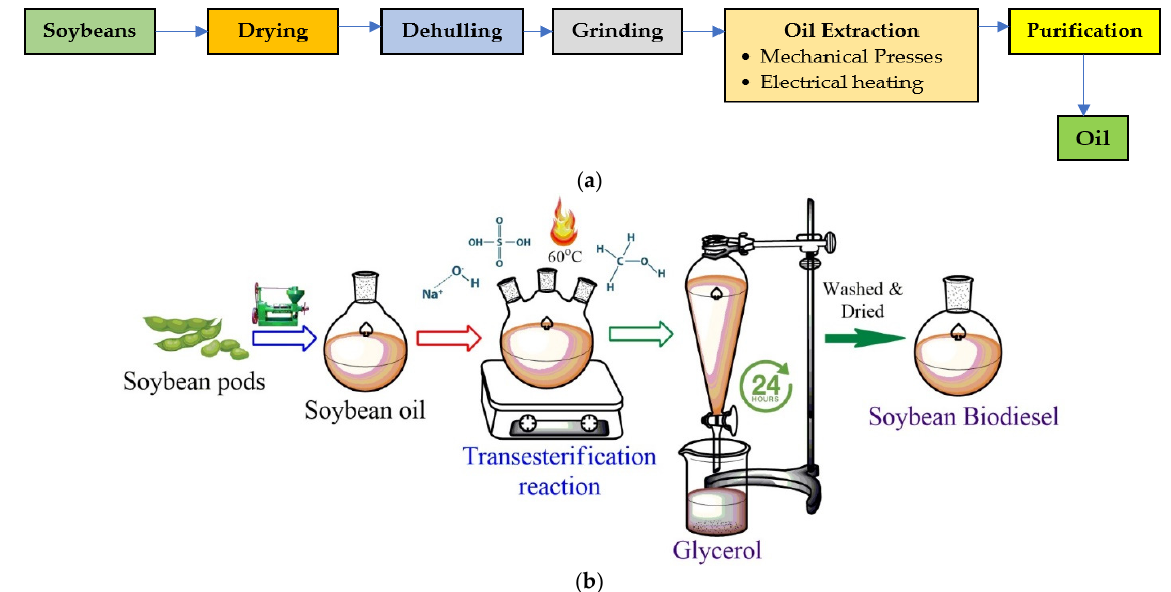
Figure 2. ( a ) Steps involved in the production of soybean oil from beans; ( b ) schematic representation of the transesterification reaction [11,27].